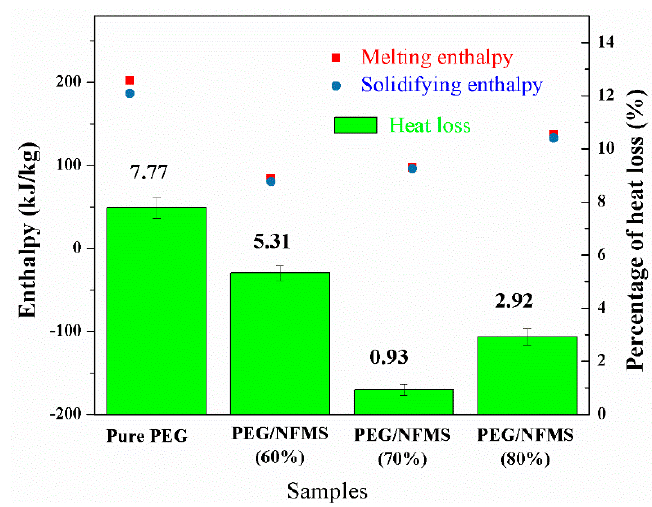
Figure 9. Comparisons of phase change enthalpy and heat loss percentage for pure PEG and PEG/NFMS.